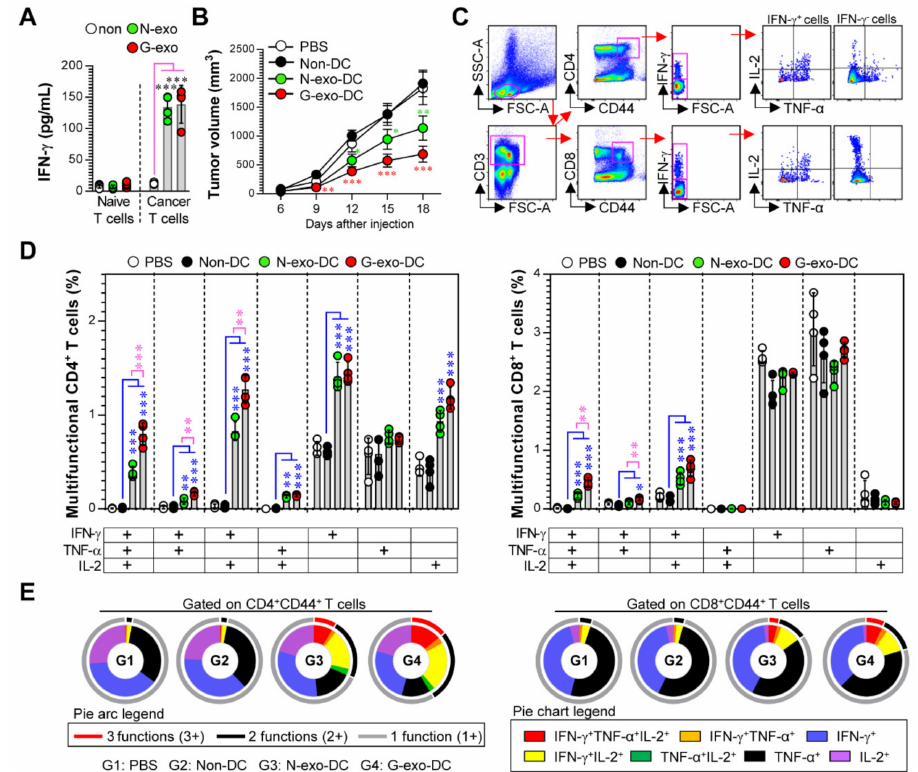
Figure 4. Analysis of antigenicity, immunogenicity, and vaccine e ffi cacy of N-exo- and G-exo in tumor-bearing mice. ( A ) Spleen cells ( n = 4) isolated from mice inoculated with melanoma cancer cells on the 18th day post-injection were treated with N-exo (25 µ g / mL) and G-exo (25 µ g / mL) for 24 h and IFN- γ secretion levels were analyzed using ELISA. ( B – E ) Mice inoculated with melanoma cancer cells were vaccinated three times at 3-day intervals with PBS only, immature DCs (Non-DCs), N-exo-loaded DCs (N-exo-DC), and G-exo-loaded DCs (G-exo-DC). ( B ) Tumor growth of vaccinated mice ( n = 7 per group). One-way ANOVA test was used to evaluate significance. * p < 0.05, ** p < 0.01, *** p < 0.001, when compared to non-DC group. ( C – E ) On the 18th day after tumor inoculation, spleen cells from each group were isolated and stimulated with melanoma cell lysates (10 µ g / mL) for 12 h in the presence of GolgiPlug and GolgiStop. Cells were then stained with T cell Abs and intracellular cytokine detection Abs as described in the Section 2 ( n = 4 per group). ( C ) The gating strategy of tumor antigen-specific multifunctional CD4 + and CD8 + T cells. ( D ) The percentage of tumor antigen-specific multiple cytokine (IFN- γ , TNF- α , and / or IL-2)-expressing cells between splenic CD4 + CD44 + and CD8 + CD44 + T cells. ( E ) The pie charts present the mean frequencies of cells co-expressing IFN- γ , TNF- α , and / or IL-2. * p < 0.05, ** p < 0.01, *** p < 0.001. PBS: tumor only-injected mice,